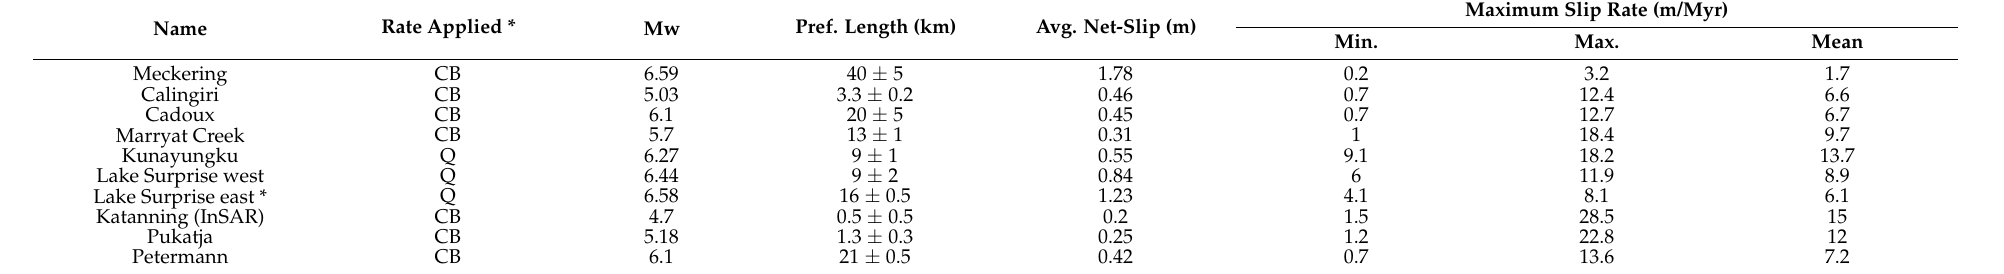
Table 9. Maximum slip rates based on minimum and maximum bedrock erosion rates [109,138] and length-weighted average net-slip values (Table 6).